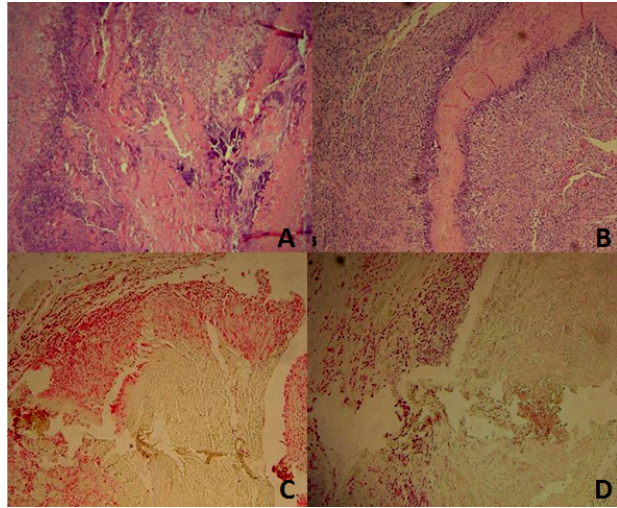
Fig. 4 - Light microscopy showing intense inflammatory reaction, with the presence of lymphocytes, histiocytes, and plasma cells in all groups studied. A) Control bovine pericardium group; B) study bovine pericardium group; C) control porcine aortic leaflets group; D) study porcine aortic leaflets group.